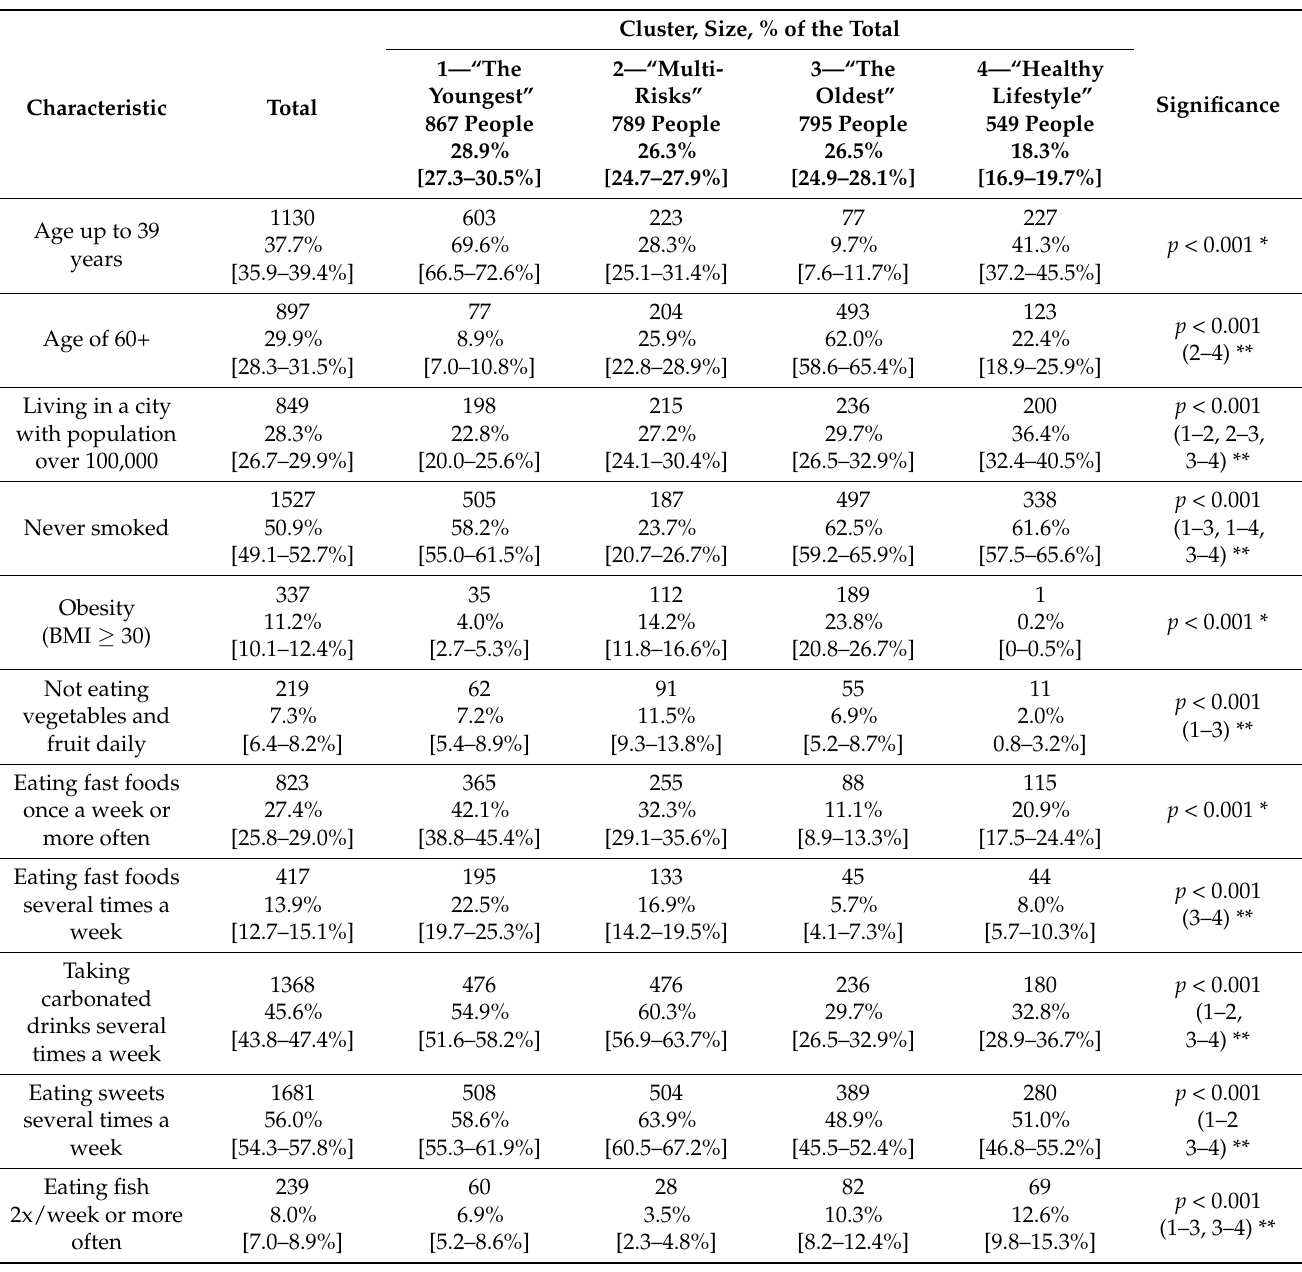
Table 3. Characteristics of the analysed population and four distinguished clusters within the scope of features not acknowledged in the clustering procedure (number and percentage of people with a particular feature; limits of 95% confidence interval in square brackets; statistical significance of differences between